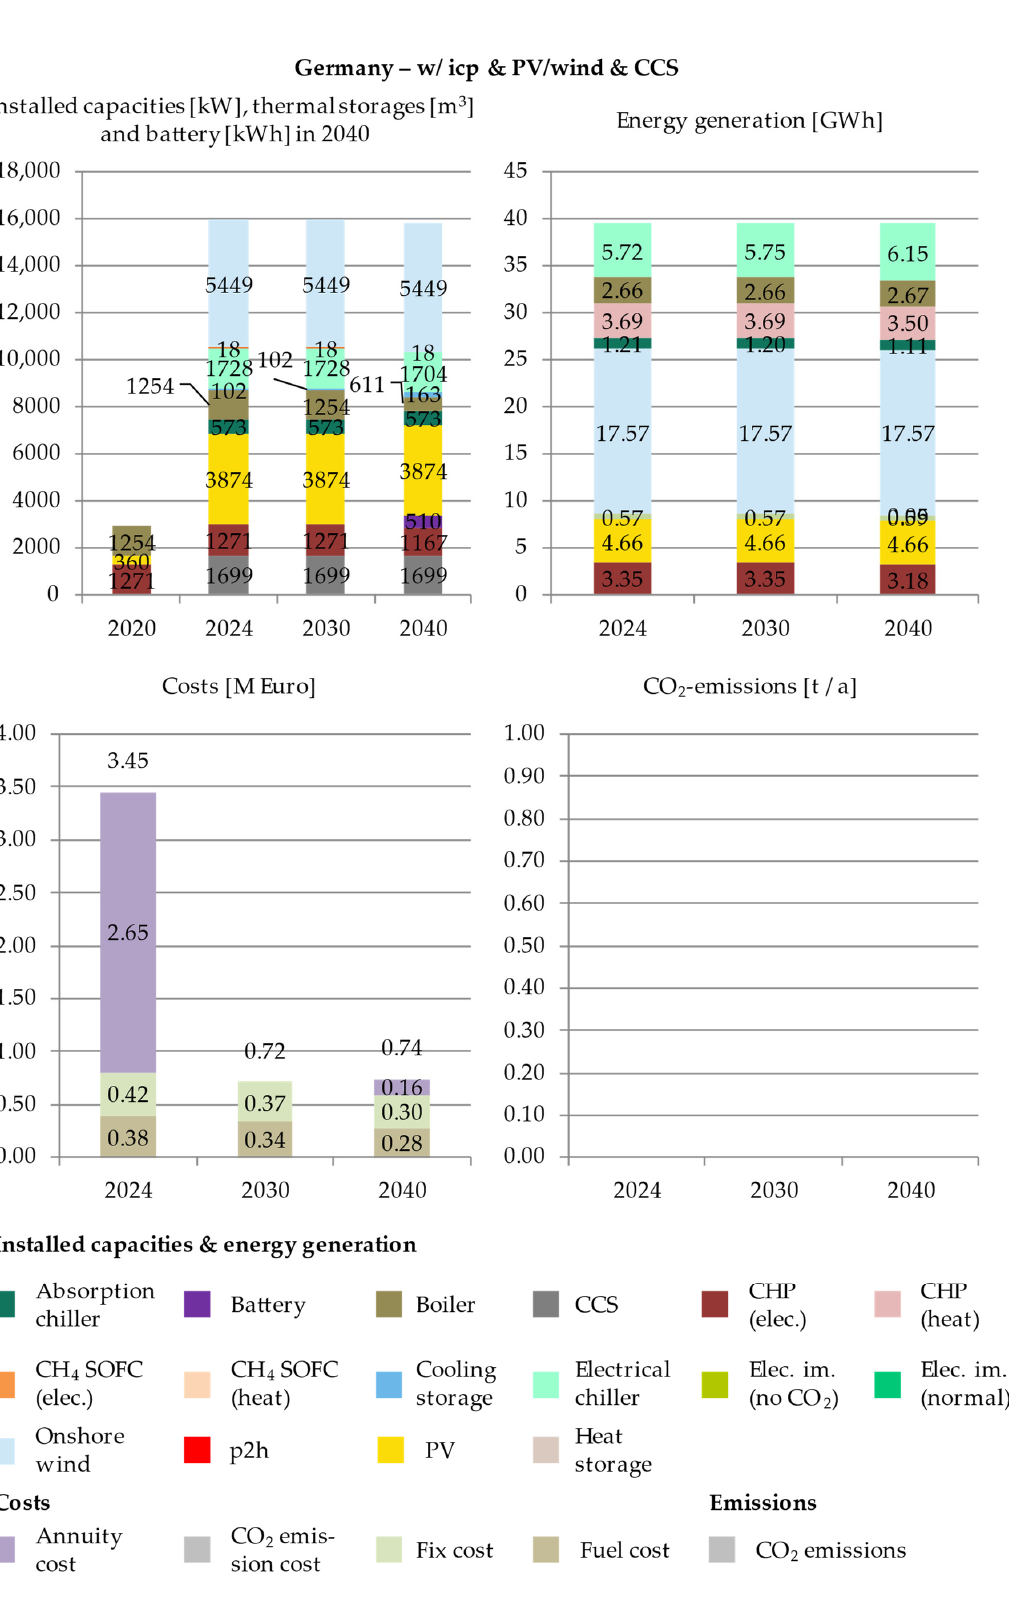
Figure A5. Detailed results for the German “w/ICP and PV/wind and CCS” scenario.